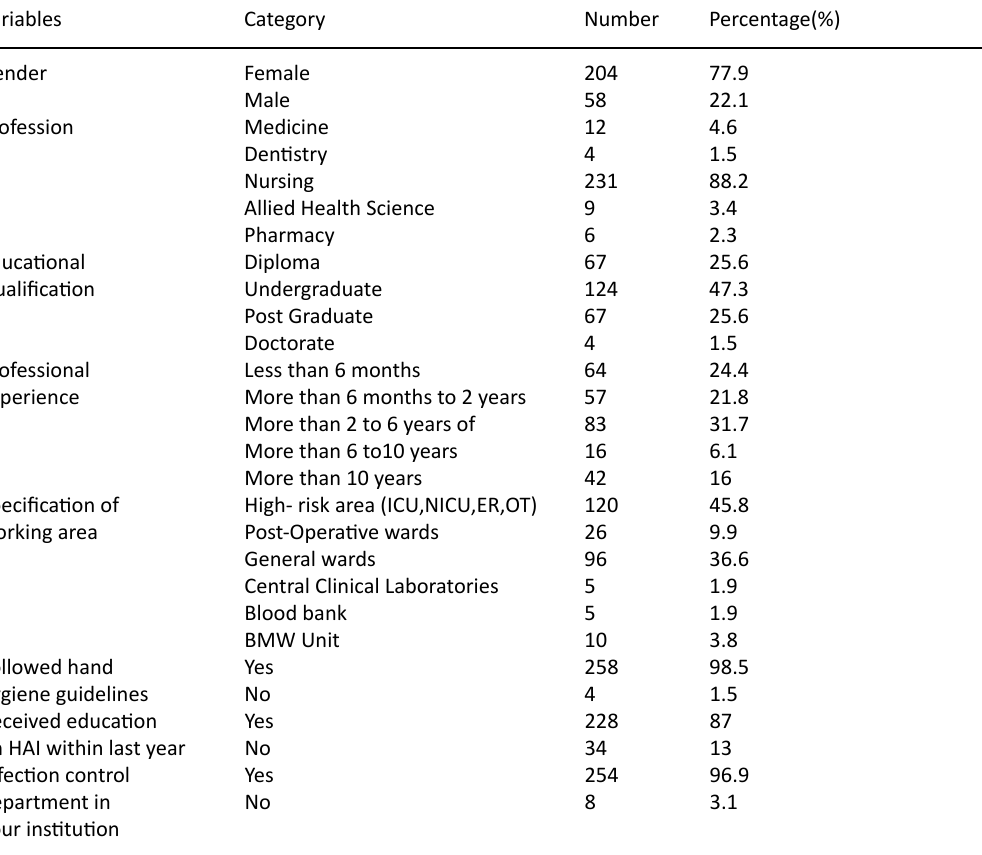
Table 1. Demographic information of health care professionals (n = 262)